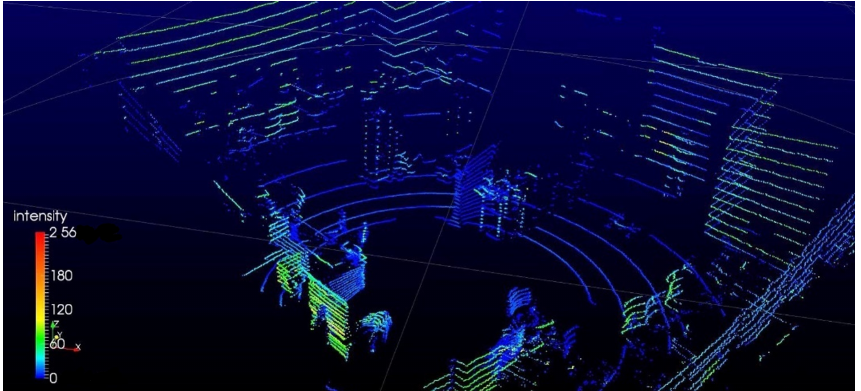
Figure 1. Architecture of autonomous driving system.